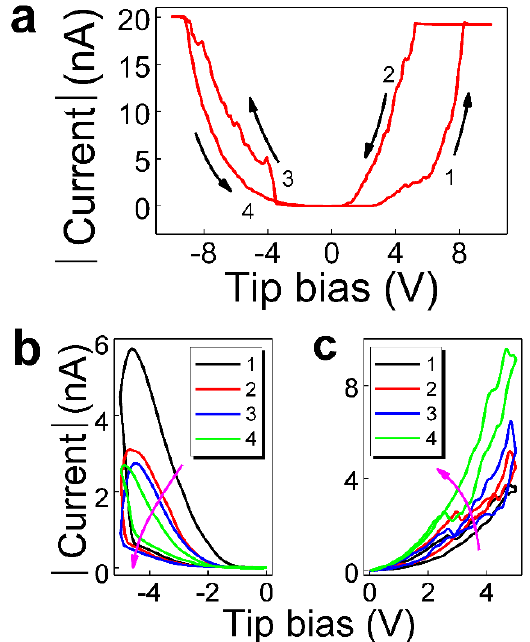
Figure 5. Memristive properties of individual conduction channels. Typical current–voltage ( I-V ) characteristics measured under ( a ) a bipolar voltage scan of 0 → +10 V → 0 → −10 V → 0, and unipolar voltage scans of ( b ) 0 → −5 V → 0 and ( c ) 0 → +5 V → 0.